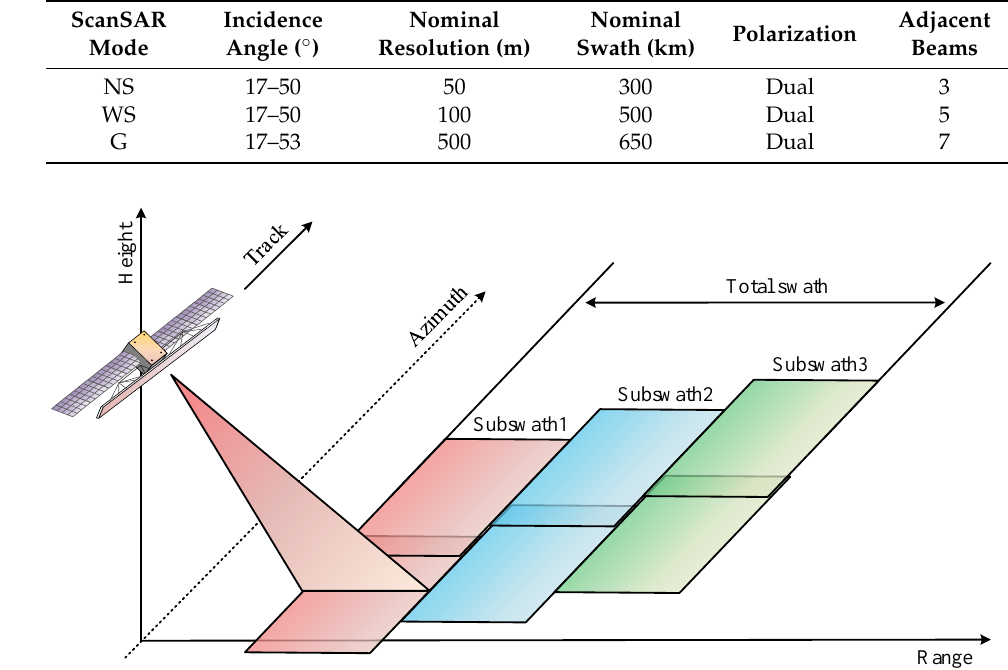
Figure 1. Spaceborne ScanSAR working mechanism of GF-3.